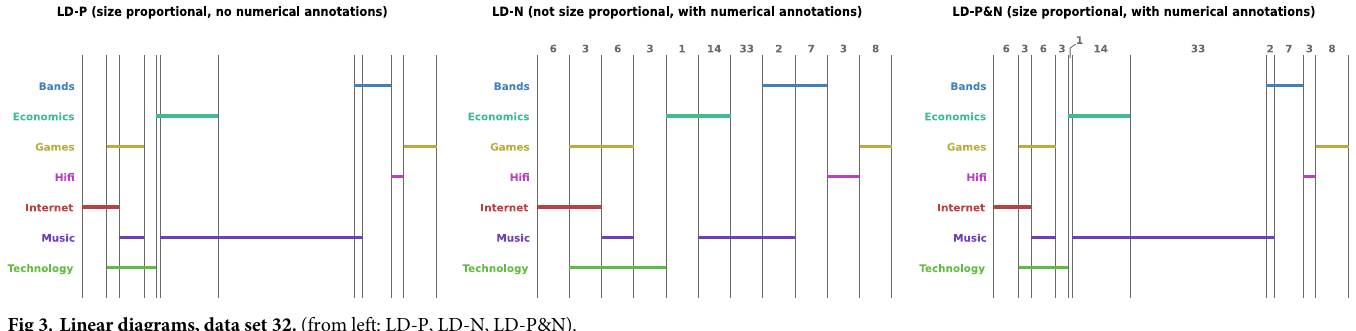
PLOS ONE | https://doi.org/10.1371/journal.pone.0211234 March 28,